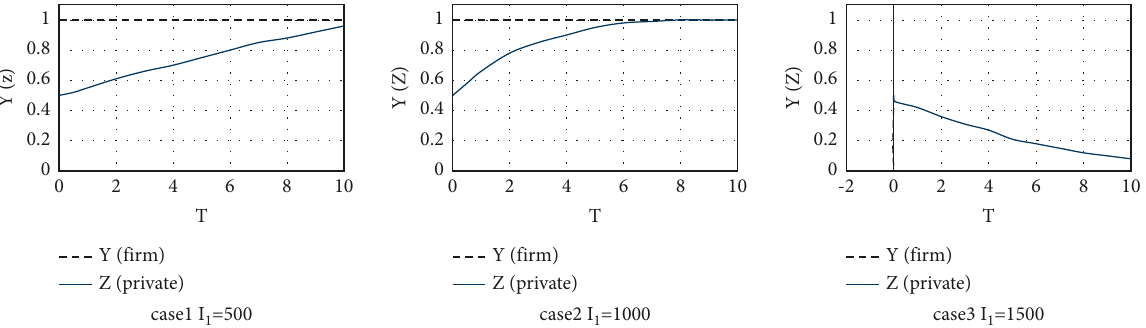
Figure 1: I 1 impact of changes on the evolution of co-created value.